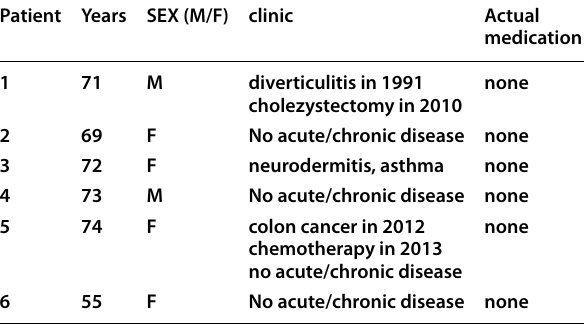
Table 1 Demographic and clinical characteristics of the patients enrolled in the